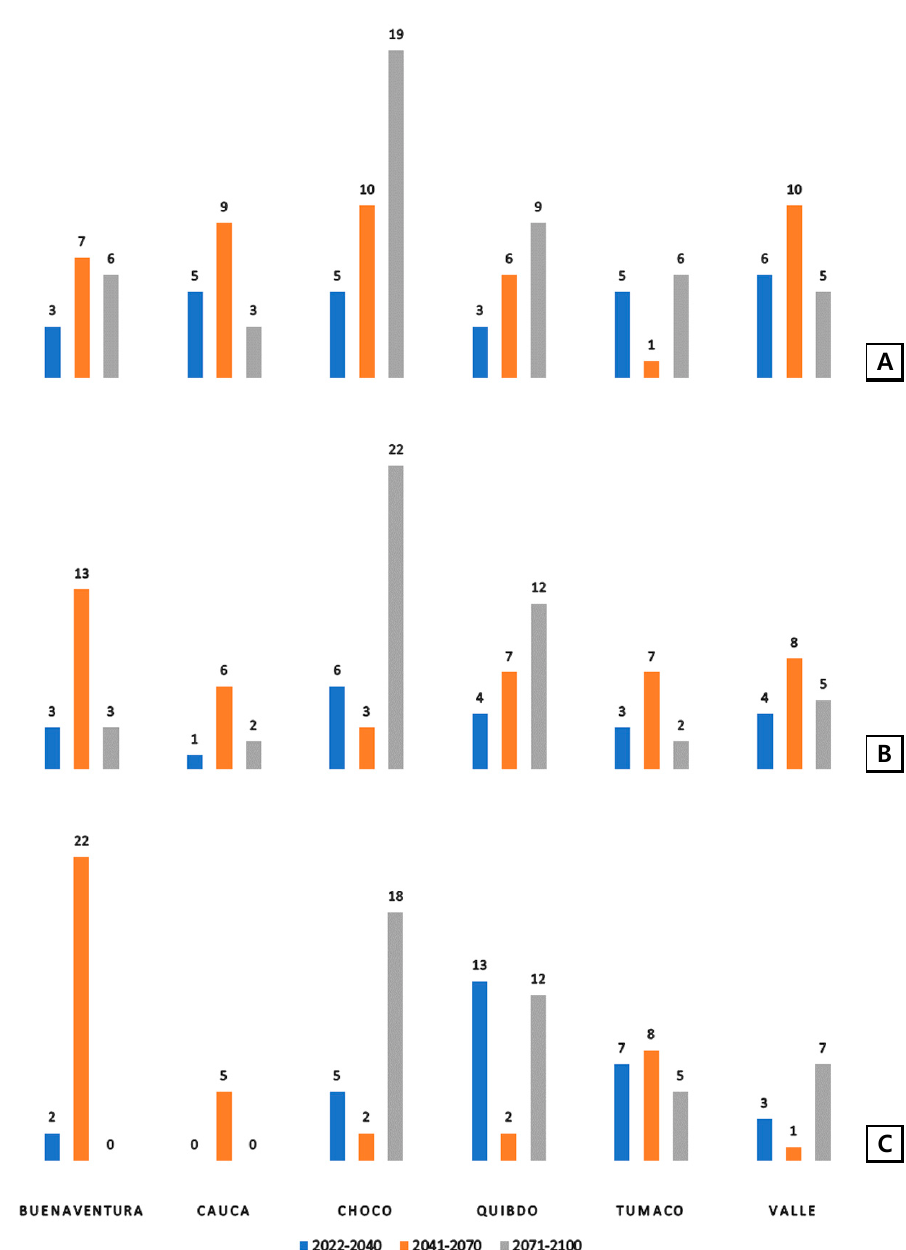
Figure 9. Number of Extremely Wet events in Colombia’s Pacific region under RCP 4.5 (2022–2200). ( A ) SPI 3; ( B ) SPI 6; and ( C ) SPI 12. Under RCP 8.5 forcing, there was a significant increase in the projected incidence of Extremely Wet events in Quibdo and Valle from 2071 to 2100 (Figure 10). Compared to the projections under RCP 4.5, Buenaventura showed a significant decrease in the incidence of Extremely Wet events. In the 2070–2100 period, SPI 3, SPI 6, and SPI 12 assessments recorded, respectively, 57, 123, and 157 months affected by Extreme Wetness. Our analysis thus demonstrated that, under the RCP 8.5 scenario, 2071–2100 is projected to be the period most severely impacted by extreme weather in the 21st